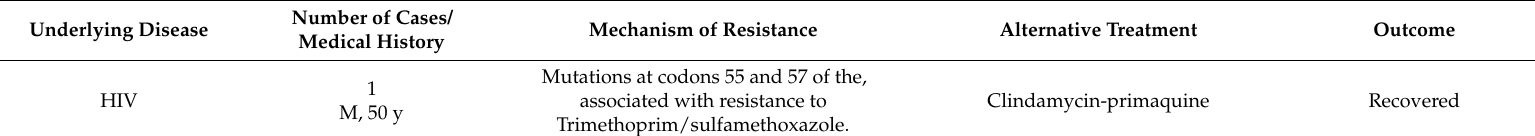
Table 5. A selection of clinical cases reporting resistant Pneumocystis